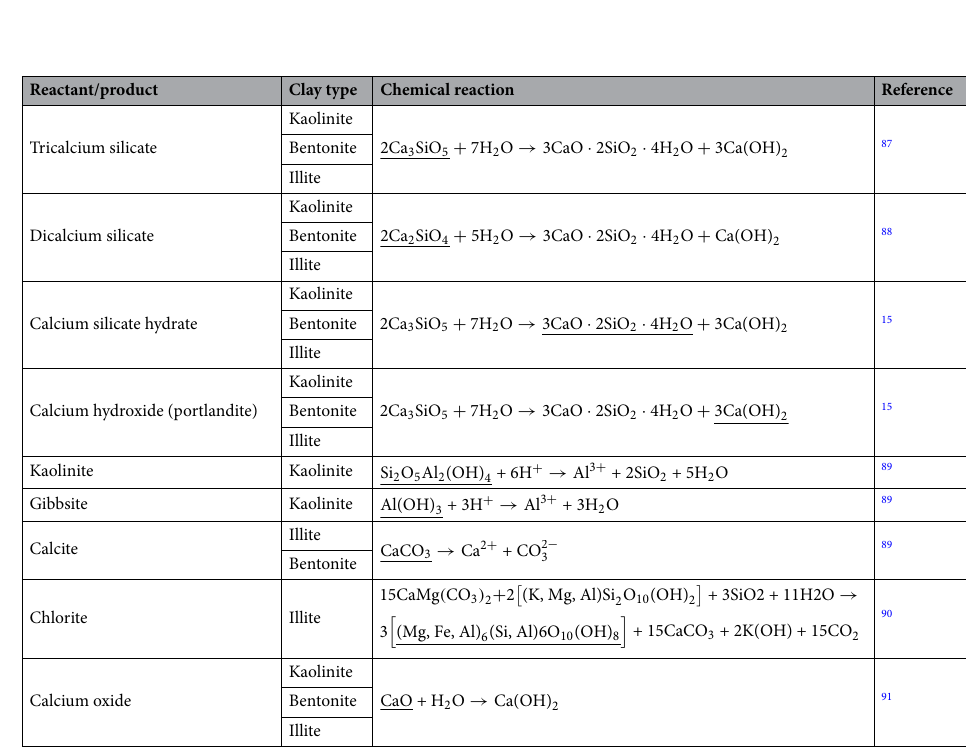
Table 5. Chemical reactions of clay minerals and Portland cement in an aqueous